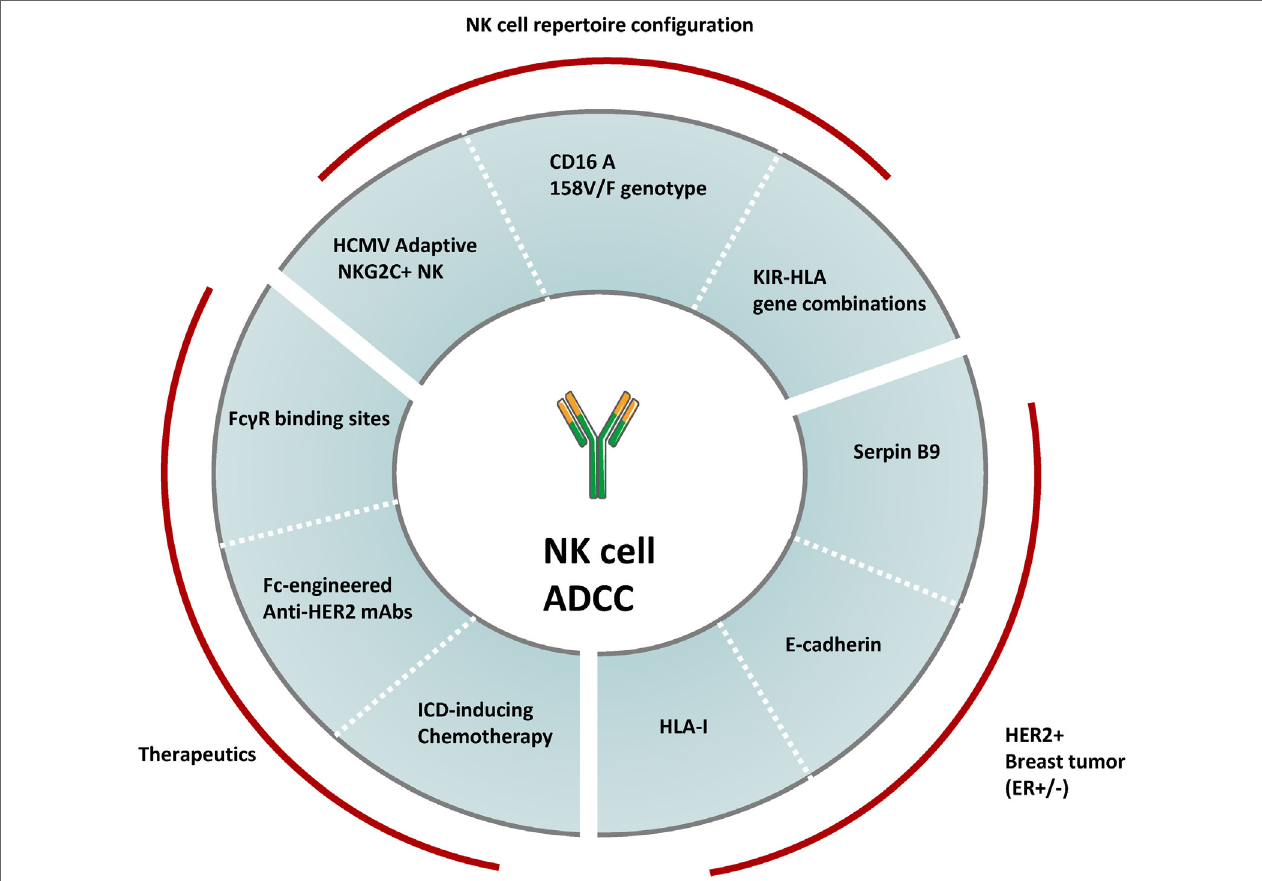
FiGURe 2 | Variables modulating NK cell-mediated ADCC against HER2 + breast cancer. The overall magnitude of NK cell-mediated ADCC induced by anti-HER2 therapeutic monoclonal antibodies can be modulated by several factors including the configuration of the human NK cell repertoire, the heterogeneity in HER2 + breast tumor molecular subtypes and differences in treatment regimens. Factors such as specific KIR-HLA combinations, the CD16A 158V/F genotype and the prevalence of human cytomegalovirus (HCMV) adaptive NKG2C + NK cells have been shown to modulate the overall NK cell-mediated ADCC potential. A number of tumor molecular features associated to estrogen receptor (ER) co-expression (e.g., expression of Serpin B9, E-cadherin, and HLA-I) can also modulate NK cell- mediated ADCC responses. Finally, the NK cell effector potential against HER2 + breast cancer is also modulated by therapeutic regimens, including the type of HER2-targeting drugs and the combined chemotherapy